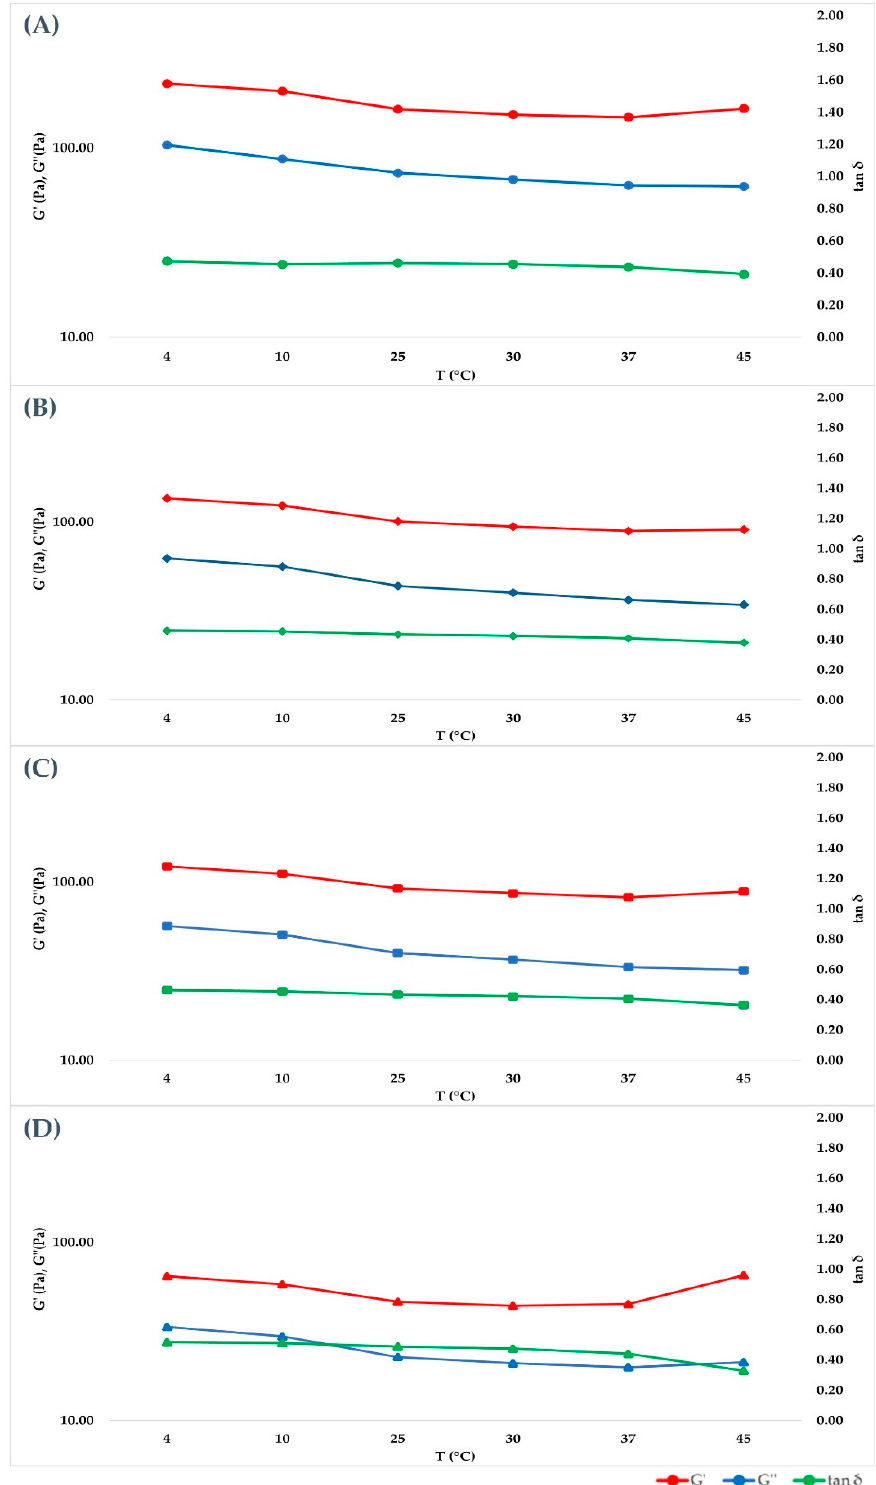
Figure 3. Cross-linked HA hydrogels show G’ higher than G” at every temperature point, showing the prevalence of elastic behavior on the viscous component. ( A – D ) are graphical representations of the cross-linked HA 28, 26, 24 and 22 mg/mL trends, increasing frequency.